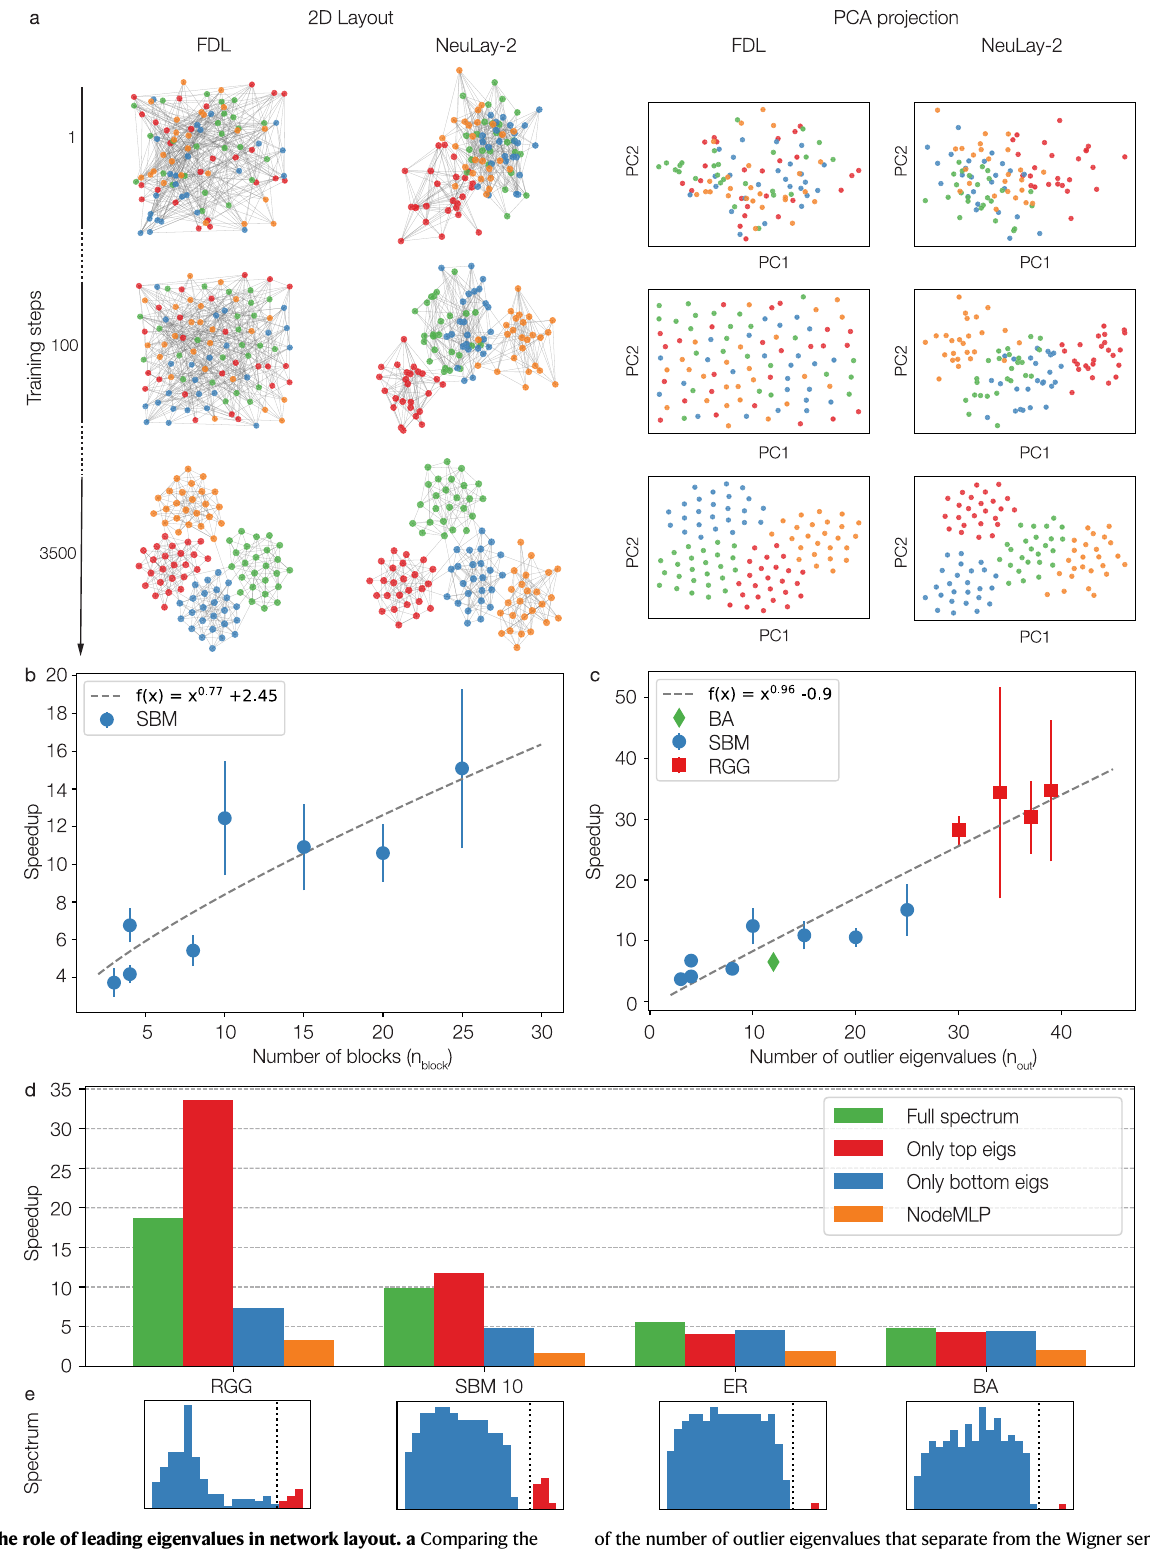
of the number of outlier eigenvalues that separate from the Wigner semicircle, indicating that the higher number of outlier eigenvalues yield higher speedup. d The NeuLay-2 performance using three different graph eigenvalue decomposi- tions in GCN modules. e The spectrum line illustrates the separation ifeigenvalues included in d